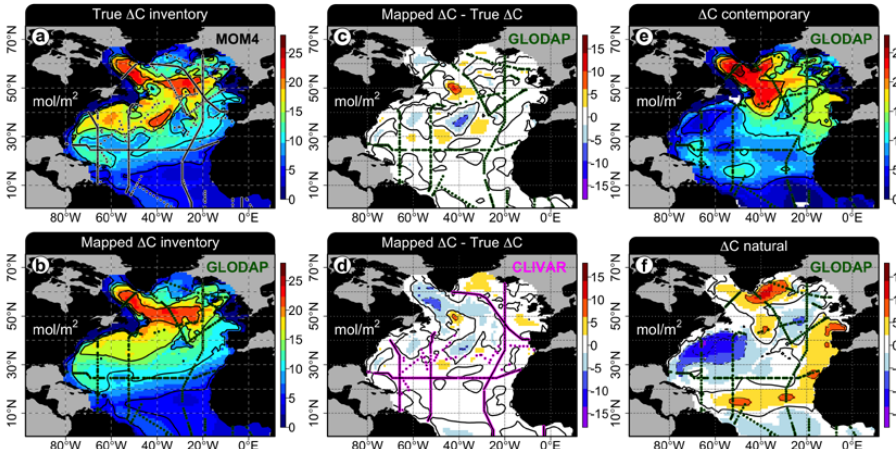
Fig. 1. (a) Change in anthropogenic carbon column inventory, in molm − 2 , between July 1995 and 2005 calculated on the original MOM4/TOPAZ grid. (b) Inventory change calculated after mapping the true values sampled at GLODAP stations. (c) Mapping error, dif- ference between (b) and (a) for GLODAP. (d) Mapping error for CLIVAR. (e) Changes in contemporary and (f) natural carbon column inventories between July 1995 and 2005 mapped from GLODAP stations. Station locations are show in green (GLODAP) or magenta (CLI- VAR). Both GLODAP and CLIVAR stations are plotted in (a) . In (c) , (d) and (f) , thin dashed (negative) and solid (positive) contour lines are drawn in increment of 6molm − 2 . Thick contours mark 0molm − 2